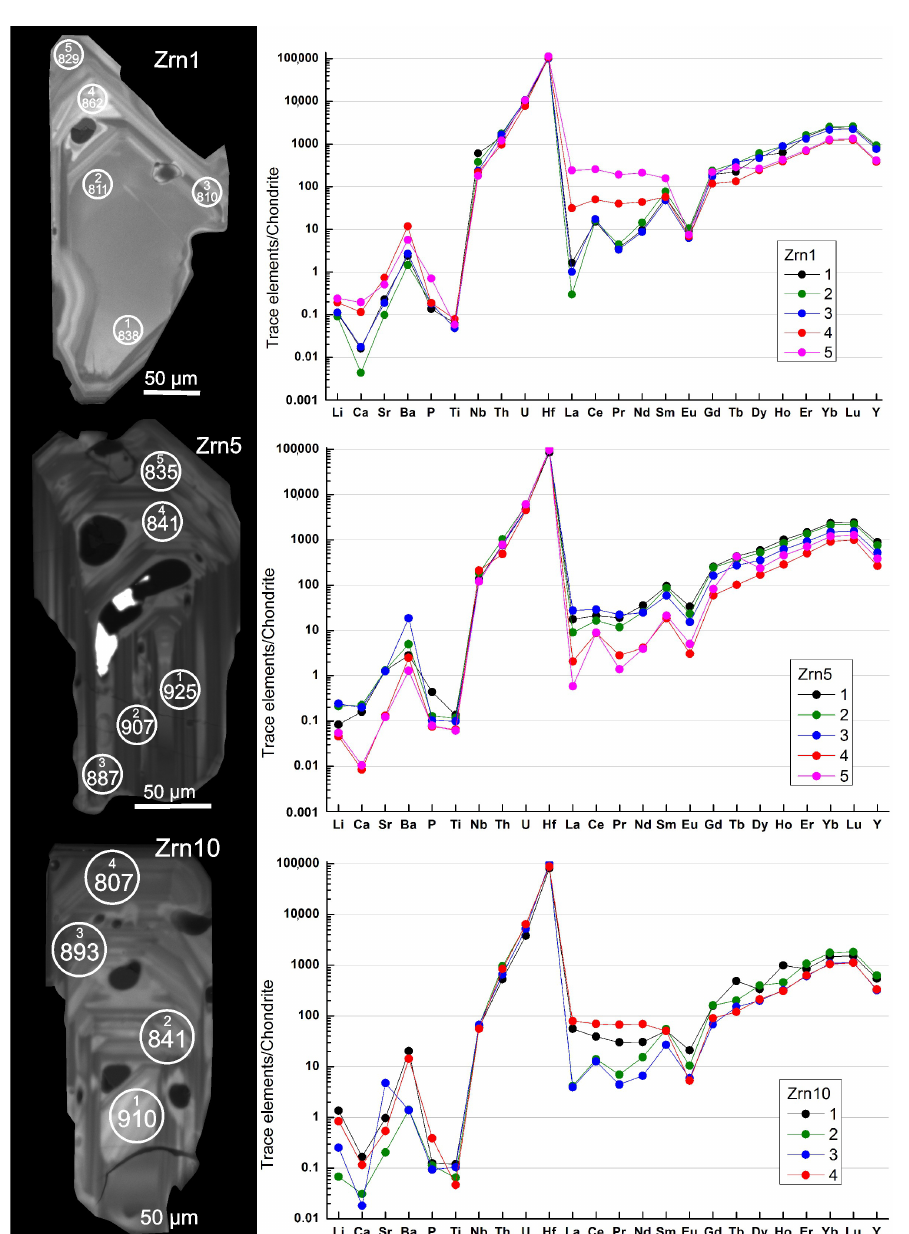
Figure 16. Images of zircons obtained by cathodoluminescence and trace elements normalized to chondrite [60]. Circle—the area analyzed by the SIMS method (diameter: 25 μm). Numbers in a circle: top—the sequence number of the analysis (see Supplementary Materials, Table S2); bottom—temperature in °C determined using a Ti thermometer [24]. Taking into account the findings of single rutile grains, it was assumed that aTi = 1. Zrn: the sequence number of an individual grain. The sequence numbers presented in the diagram and in the image are equal.